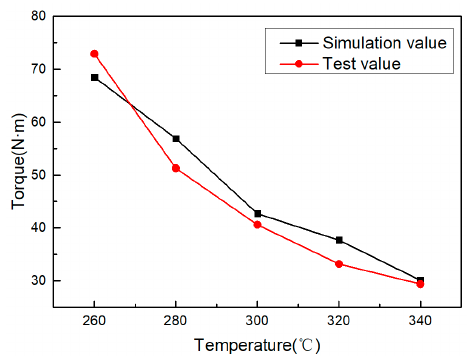
ff ect of heating temperature on torque. Figure 10. Effect of heating temperature on torque. Figure 10. E